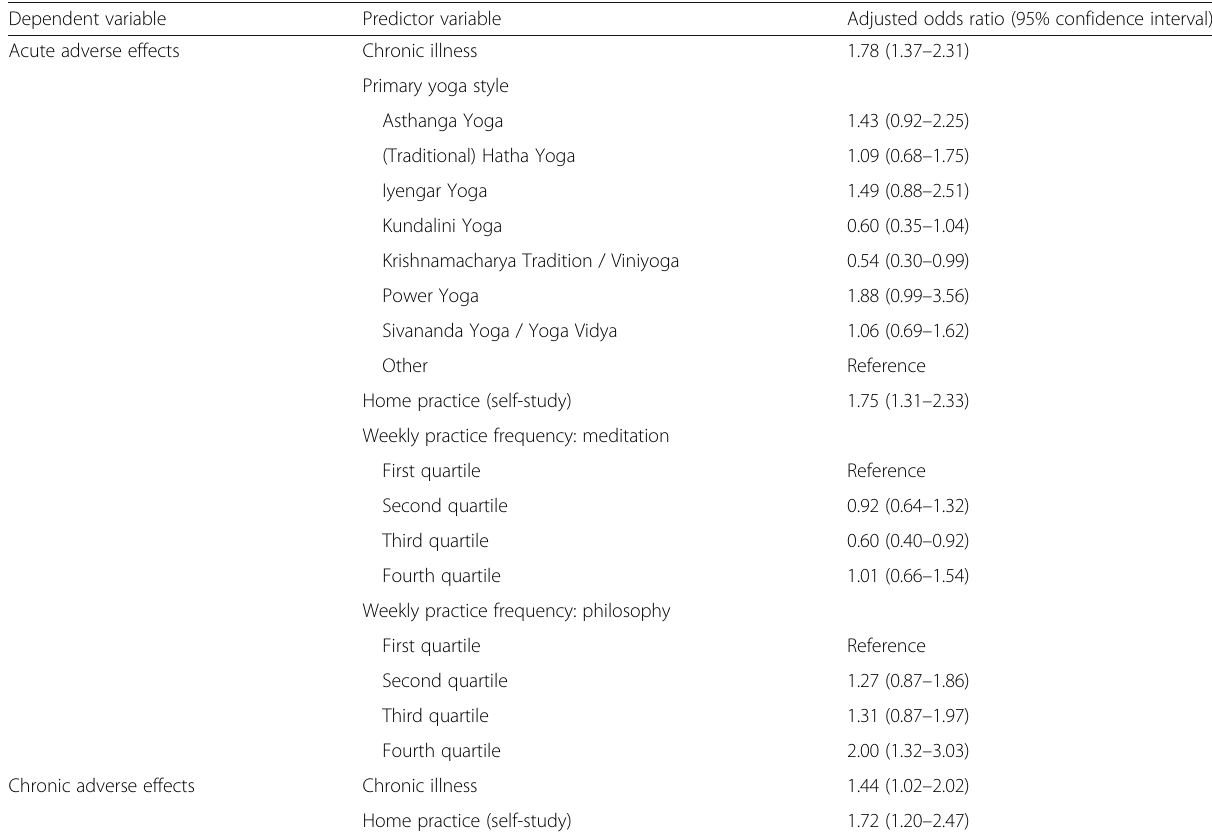
Table 3 Predictors associated independently with acute and chronic adverse effects. Only those categories of predictors are shown that were significantly associated with acute or chronic adverse effects Dependent